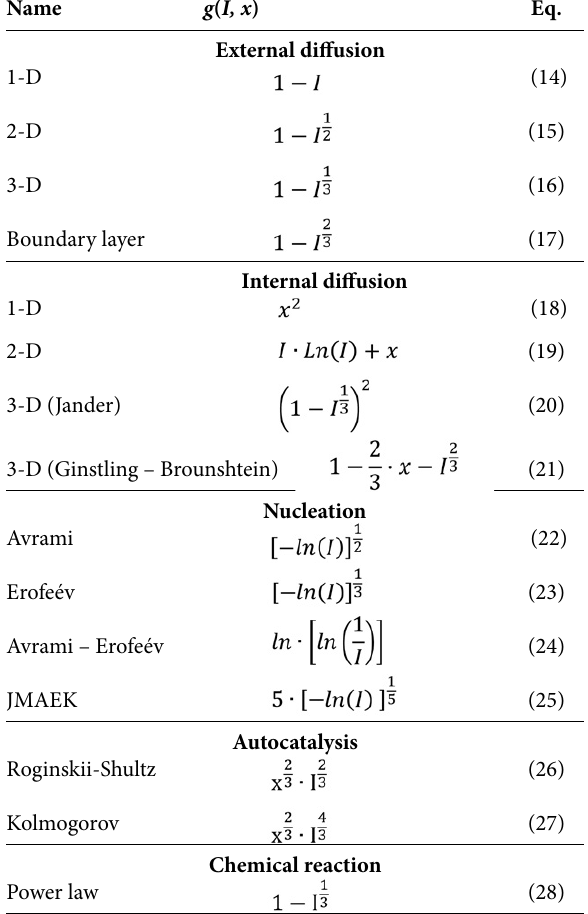
Table 2. Models used in the kinetic analysis to investigate the con- trolling mechanism in the nickel removing by electrocoagulation Name g ( I, x )